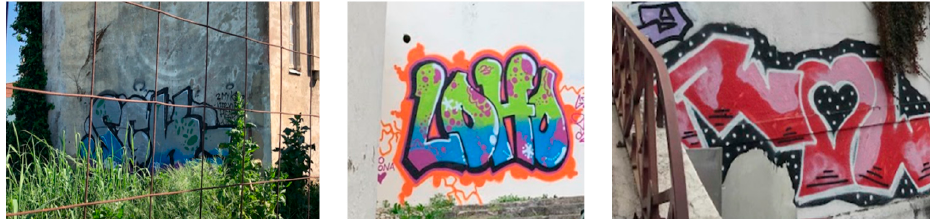
Figure 15. Images labeled as illegal graffiti.